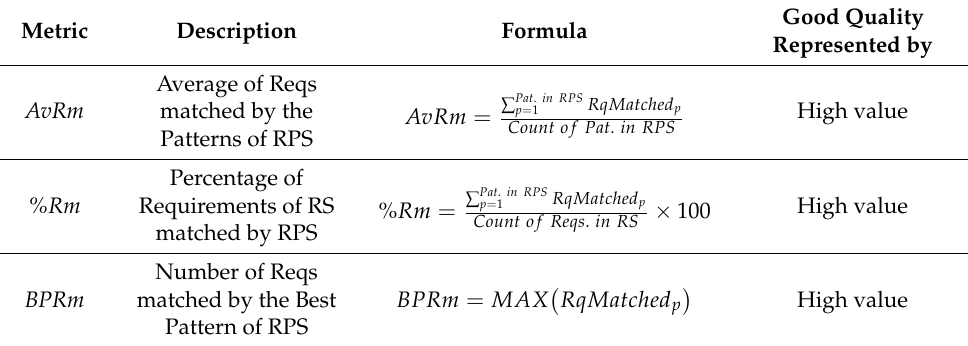
Table 4. Quality